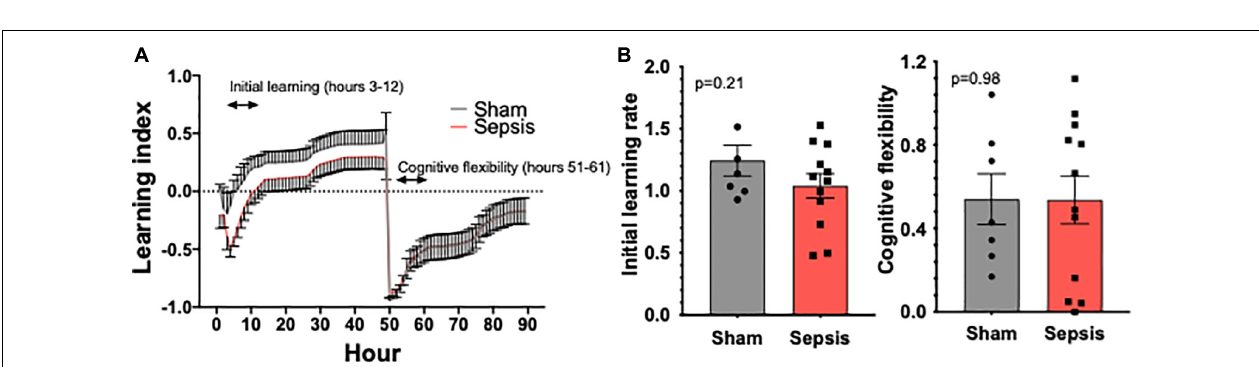
FIGURE 3 | Sepsis caused by L. monocytogenes was associated with endothelial dysfunction. Endothelium-dependent vasodilation was measured using wire myography in aorta rings under isometric conditions. (A) Sepsis significantly reduced endothelial function in aged animals. A significant difference in dilation between groups was observed when 4 µ M acetylcholine (ACh) was applied to aorta rings. (B) Endothelium-independent relaxation evoked by sodium nitroprusside (SNP) was not different between groups (right panel). * p < 0.05; ** p < 0.01.